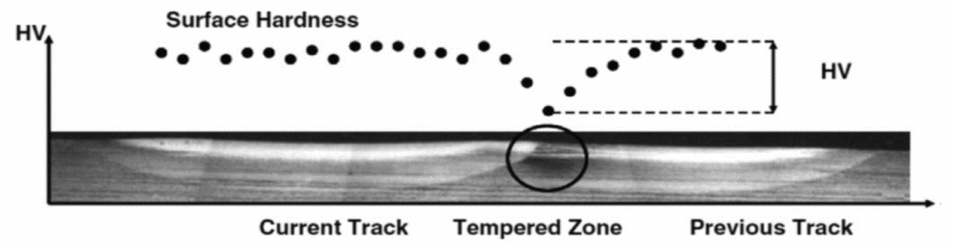
Figure 10. Back-tempering process in laser hardness